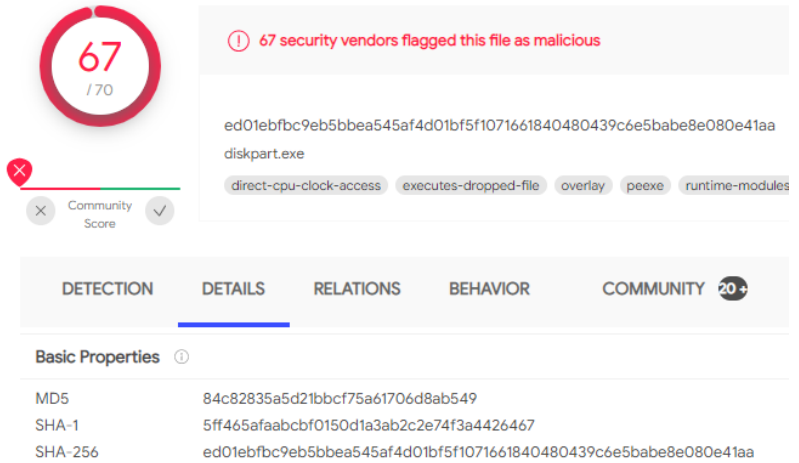
Figure 3. Submission of the WannaCry executable to VirusTotal with generated